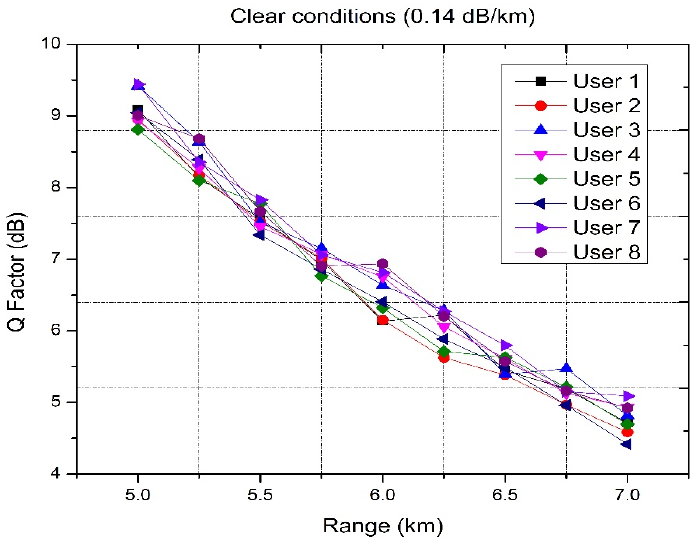
Figure 3. Q-factor of FSO-PDM/PV-OCDMA system versus FSO link under clear air weather.